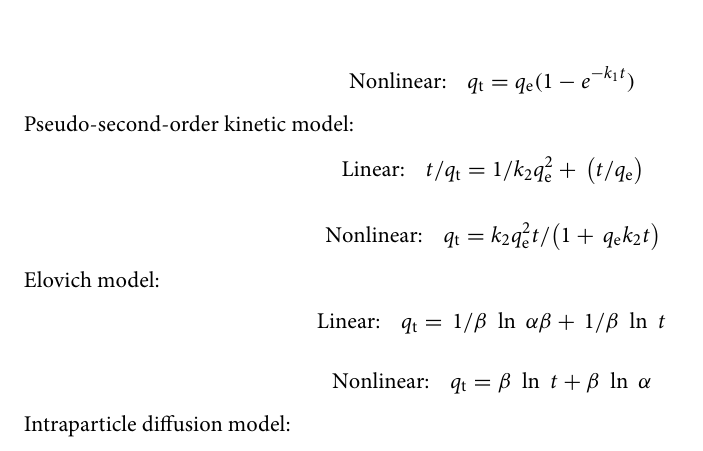
Table 9. The chemical characteristic and structure of RB4